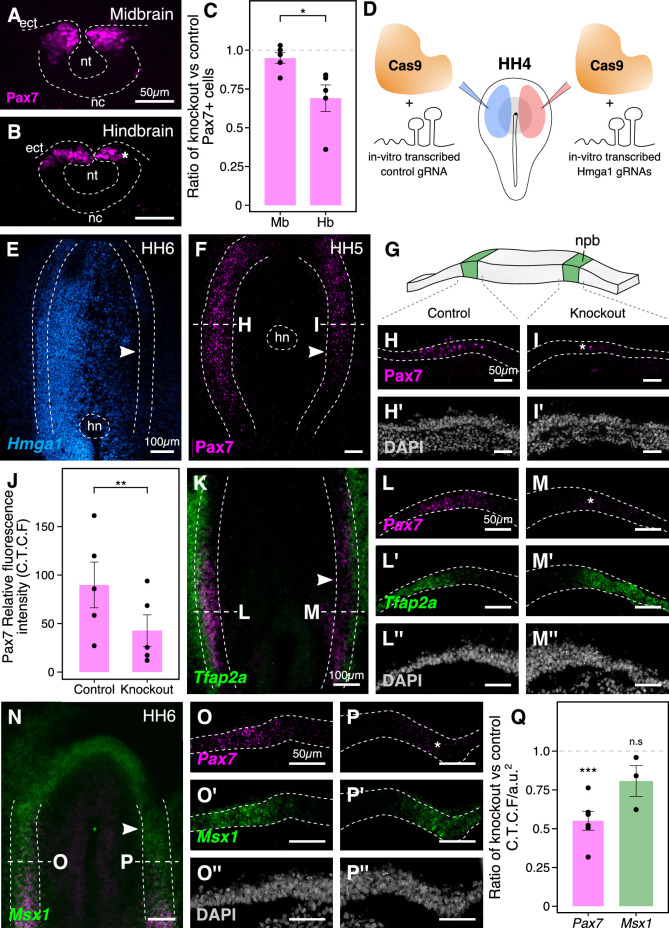
The effects of Hmga1 knockout on neural crest specification are Pax7-dependent.(A-B) Transverse sections through a representative embryo show a dramatic reduction in the number of Pax7+ cells in the hindbrain (B, asterisk) as compared to the midbrain (A) at HH9/9+. As the hindbrain develops later than the midbrain due to the anterior-posterior progression of neural development, the effect on neural crest specification is more penetrant in the hindbrain (asterisk) due to the time lag between Cas9 plasmid electroporation and its activation in transfected cells. (C) The ratio of Pax7+ cells between the experimental and control sides quantified at the midbrain and hindbrain levels is significantly different (*p<0.05; student’s t-test). A ratio of 1 (dotted line) corresponds to a similar number of Pax7+ cells on both sides. (D) Electroporation strategy for knocking out Hmga1 using Cas9 protein and in vitro-transcribed gRNAs. This strategy was used to immediately reduce the levels of Hmga1 on the knockout side. (E) HCR against Hmga1 in mutant embryos shows dramatic transcriptional reduction on the experimental side (arrowhead). (F) Cas9-protein-mediated loss of Hmga1 resulted in downregulation of Pax7 expression in the neural plate border on the right side (experimental side; arrowhead). (G) Illustration of the neural plate border. (H–I’) Transverse section through embryo shown in F. Electroporation of the control ribonucleoprotein (RNP) complex had no effect on the expression of Pax7 in the neural plate border (H), whereas the knockout side showed an almost complete loss (I, asterisk). No difference in the thickness of the neural plate border was observed between the two sides (H’,I’). (J) Quantification of relative fluorescence intensity for Pax7 signal calculated as corrected total cell fluorescence (C.T.C.F) revealed a statistically significant difference between the control (left) and knockout (right) sides (**p<0.01, paired student’s t-test). (K–P’’) Representative Hmga1-mutant embryos that were processed for HCR against neural plate border genes Tfap2a (K; experimental side - arrowhead) and Msx1 (N; experimental side - arrowhead). While Hmga1 loss resulted in reduction of Pax7 transcripts on the experimental sides (M,P; asterisk) compared to the control sides (L,O), the expression of Tfap2a (L’,M’) and Msx1 (O’,P’) was relatively unchanged. No notable difference was observed in the thickness of the neural plate border (L’’,M’’,O’’,P’’). (Q) Transcriptional response to the loss of Hmga1 was quantified as the ratio of knockout versus control C.T.C.F per unit area. While Pax7 expression was significantly reduced (***p<0.001, paired student’s t-test), no significant difference in Msx1 expression was observed (n.s. p>0.05, paired student’s t-test). Dotted line represents unperturbed ratio. See also Figure 4—figure supplement 1; Figure 4—source data 1, Figure 4—source data 2, Figure 4—source data 3.Figure 4—source data 1.Pax7-positive cell counts in transverse sections through the midbrain and hindbrain compared between Control and Hmga1-knockout sides in panel C.Figure 4—source data 2.Pax7 corrected total cell fluorescence intensity in transverse sections through the neural plate border compared between Control and Hmga1-RNP-knockout sides in panel J.Figure 4—source data 3.Pax7 and Msx1 HCR corrected total cell fluorescence intensity in transverse sections through the neural plate border compared between Control and Hmga1-RNP-knockout sides in panel Q.